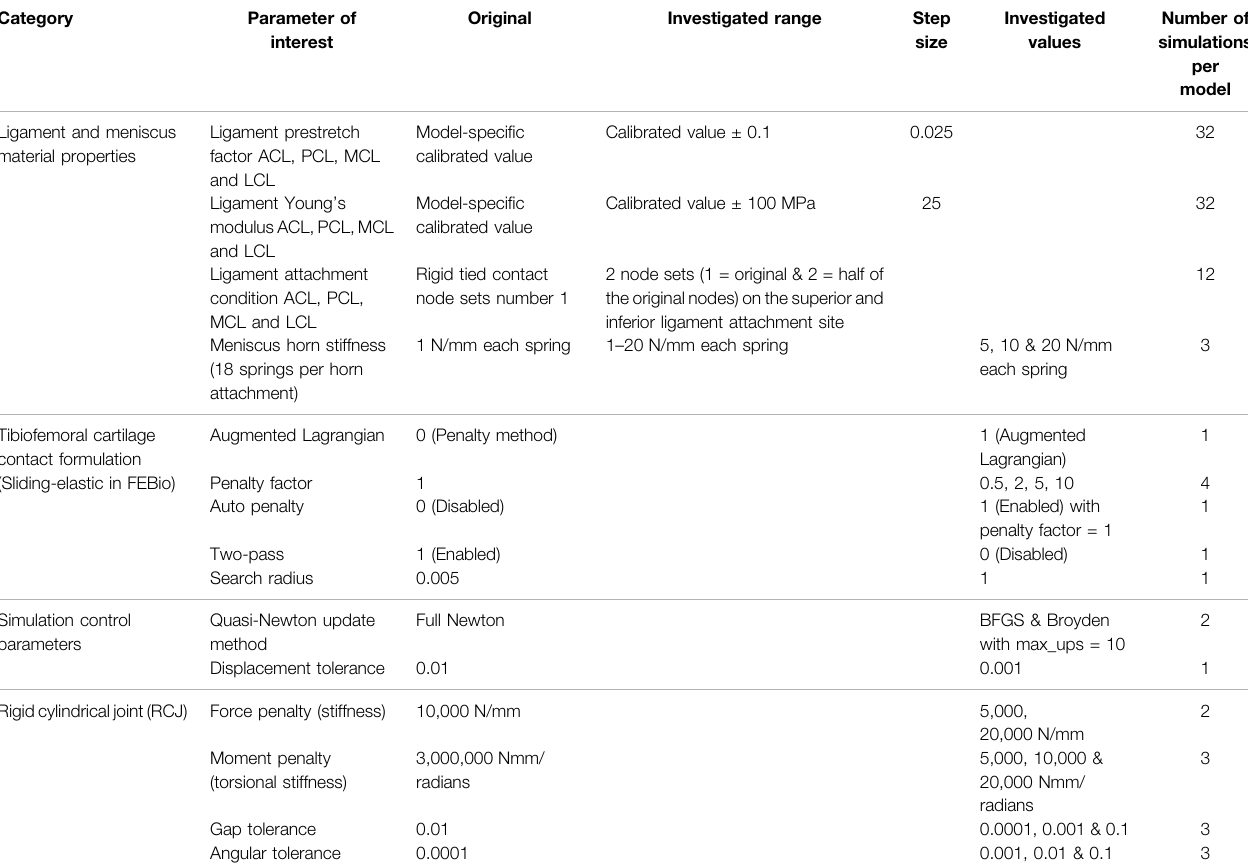
TABLE 3 | Parameters of interest and their values investigated. Ligament abbreviations: anterior and posterior cruciate ligaments (ACL & PCL) and medial and lateral collateral ligaments (MCL & LCL). Category